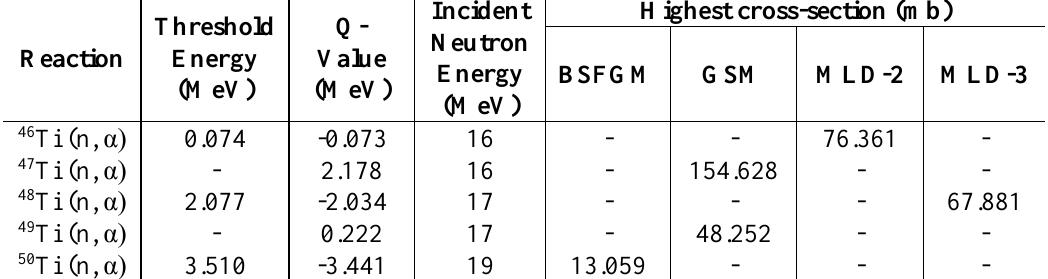
Figure 5: Comparison of the theoretically calculated excitation functions with experimental data for 50 Ti (n, α) 47 Ca reaction. Table1: Threshold energy, Q-values, and the incident neutron energies that correspond to the highest cross-section values of (n, α) nuclear reactions on 46-50 Ti